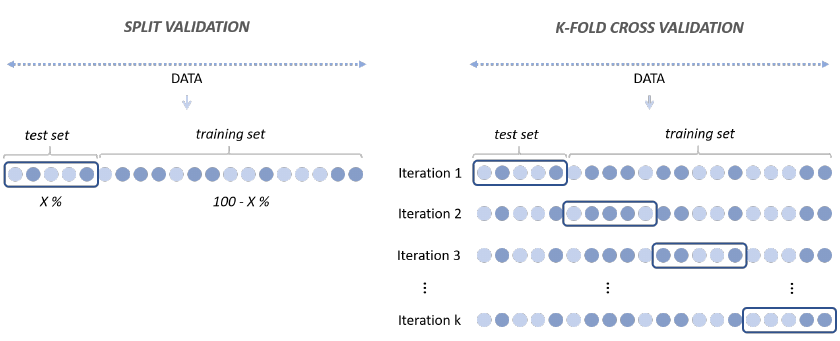
Figure 5. Comparison between Split and Cross Validation